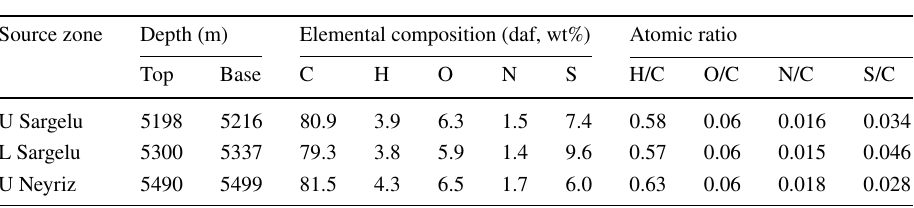
Table 1 Results of elemental analyses of the studied kerogen samples